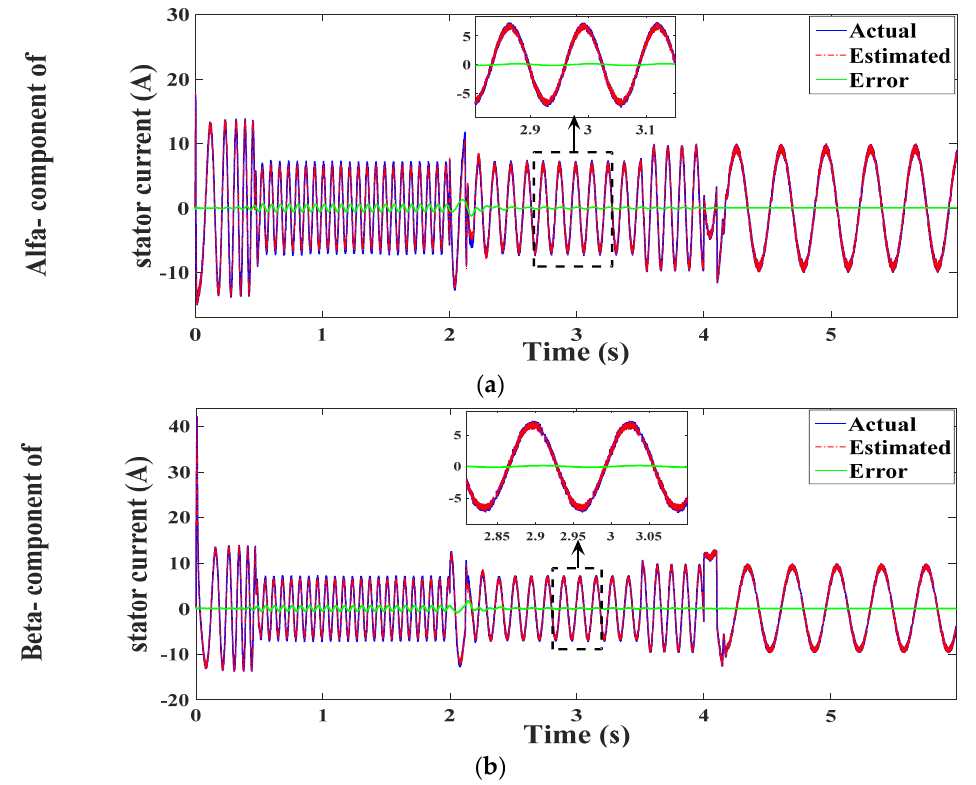
Figure 18. ( a ). Alfa-component of stator current under proposed PVC (A), ( b ). Beta-component of stator current under proposed PVC (A).